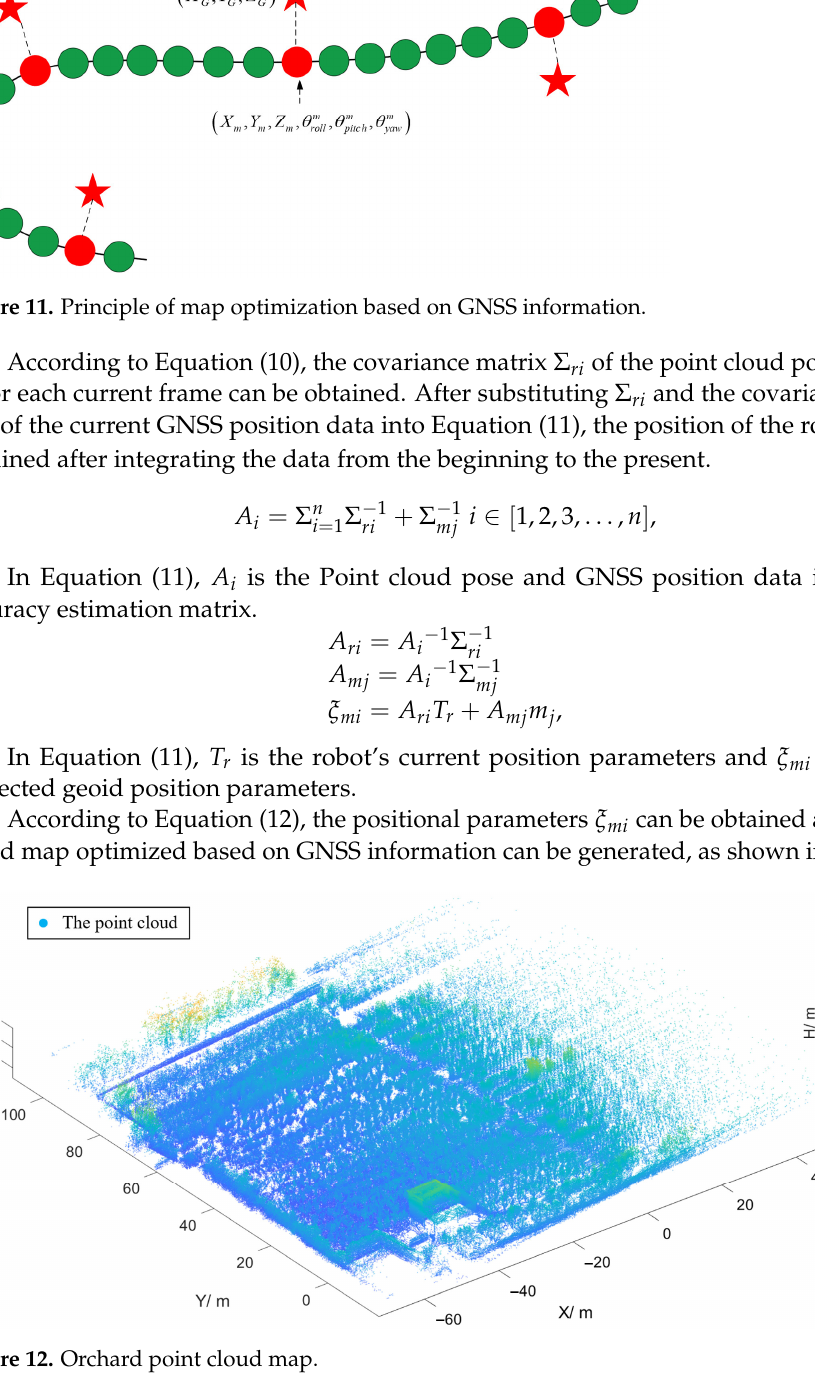
Figure 12. Orchard point cloud map.